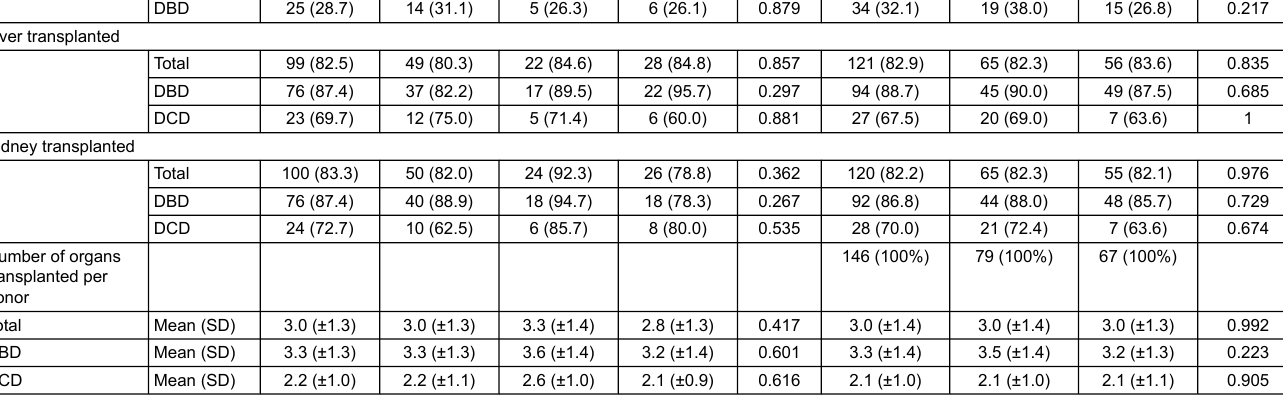
Table S1: Complete table for the analysis of the effect of CPR duration and no-flow time; included are only utilised donors (at least one organ transplanted) for whom either the duration of no-flow time, or the duration of CPR was